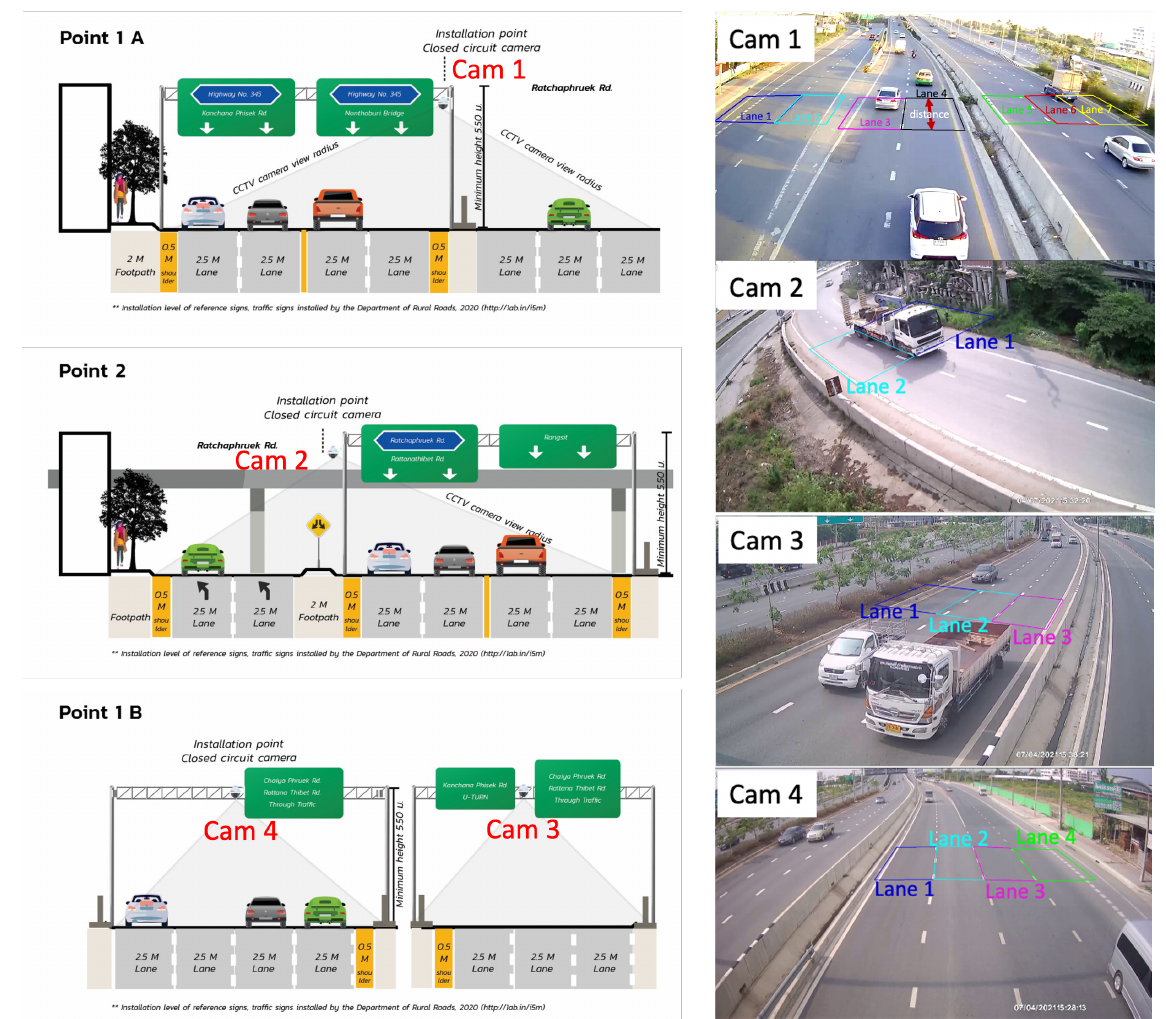
Figure 5: Experimental setup of four cameras (Cam 1, ..., Cam 4) for the validation of vehicle count and classification.